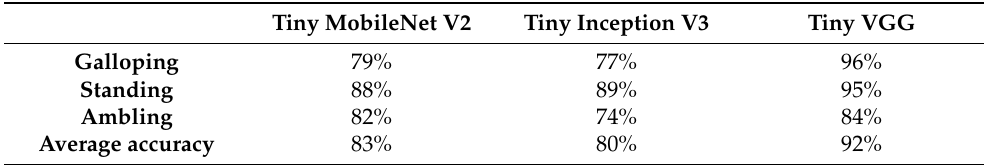
Figure 11. Convergence curve of the loss function for the three tiny convolutional networks: the blue, red, and green lines represent the convergence of the loss functions of the recognition networks Tiny VGG, Tiny Inception V3, and Tiny MobileNet V2, respectively. Table 5. Results of the three outline-based convolutional networks: different actions of wild felines produce different results for different